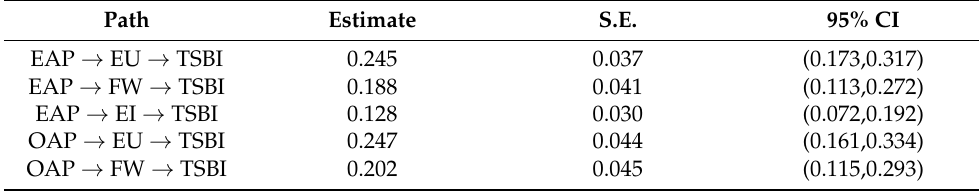
Table 5. Mediating effect